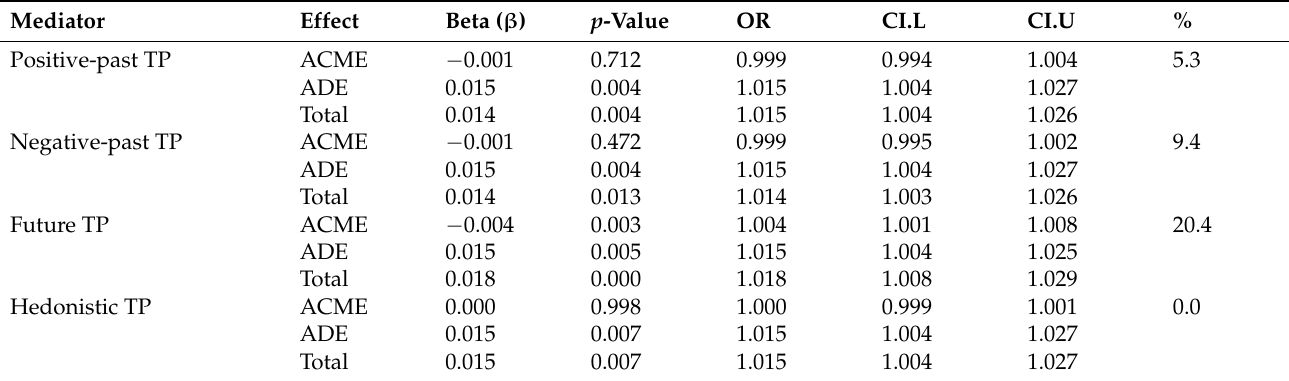
Table 2. The coefficients for each time